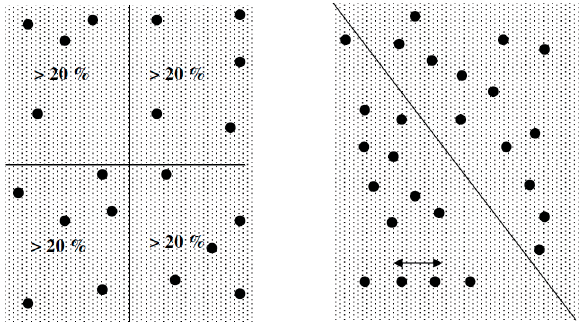
Figure 24. Distribution of CPs for data evaluation. Source: [40].